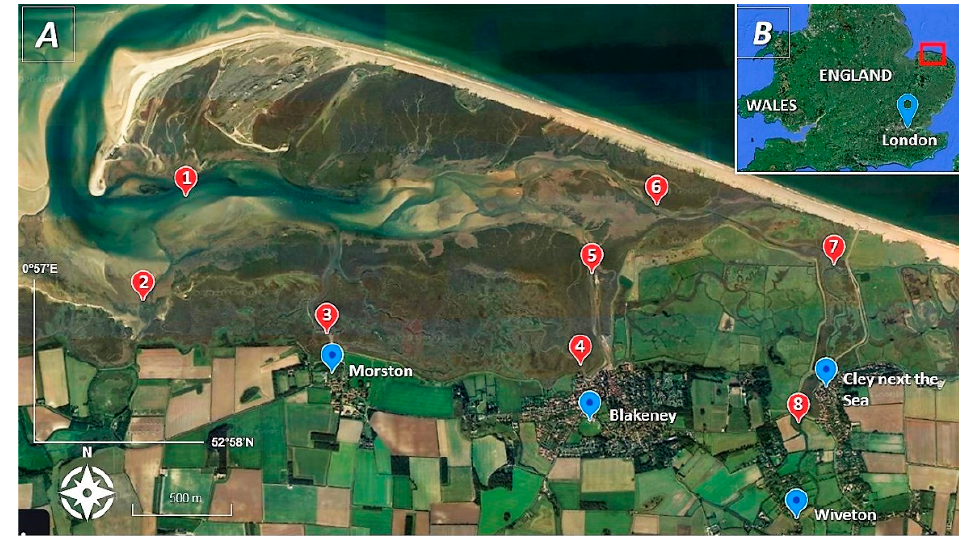
Figure 1. ( A ) Map of Blakeney Point indicating the position of sampling sites ( Landmarks, Sampling points). ( B ) Map of England and Wales: The red square shows the location of the study site.